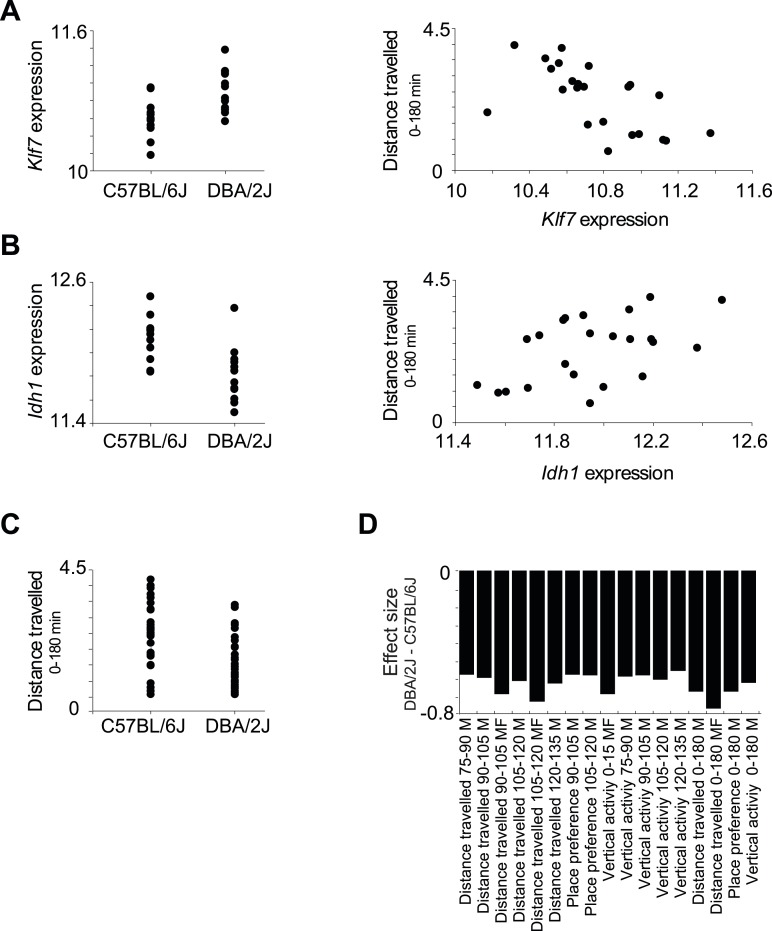
Relationships among components in module no. 2.(A) Left: Klf7 expression levels (y-axis) of all individuals carrying the C57BL/6J allele (left column) and DBA/2J allele (right column) for the representative variant rs13475891 of module no. 2. Right: Scatter plot, where for each individual the y-axis shows the measured level of a morphine-related trait (distance travelled in 0–180 min in males and females) and the x-axis shows the Klf7 expression. (B) Plots are shown as in A, but for the Idh1 transcript. (C) Level of a morphine-related trait (distance travelled in 0–180 min in males and females; y-axis) of all individuals carrying the C57BL/6J allele (left column) and the DBA/2J allele (right column). The plot shows higher levels of the morphine-related trait in C57BL/6J-carrying individuals. (D) Effect size of variant rs13475891 on the traits in module no. 2. The histogram represents average expression levels of DBA/2J-carrying individuals minus the B6-carrying individuals (y-axis) for each module trait (x-axis). The plot indicates a higher level of the morphine-related trait in C57BL/6J-carrying individuals, as exemplified in C.